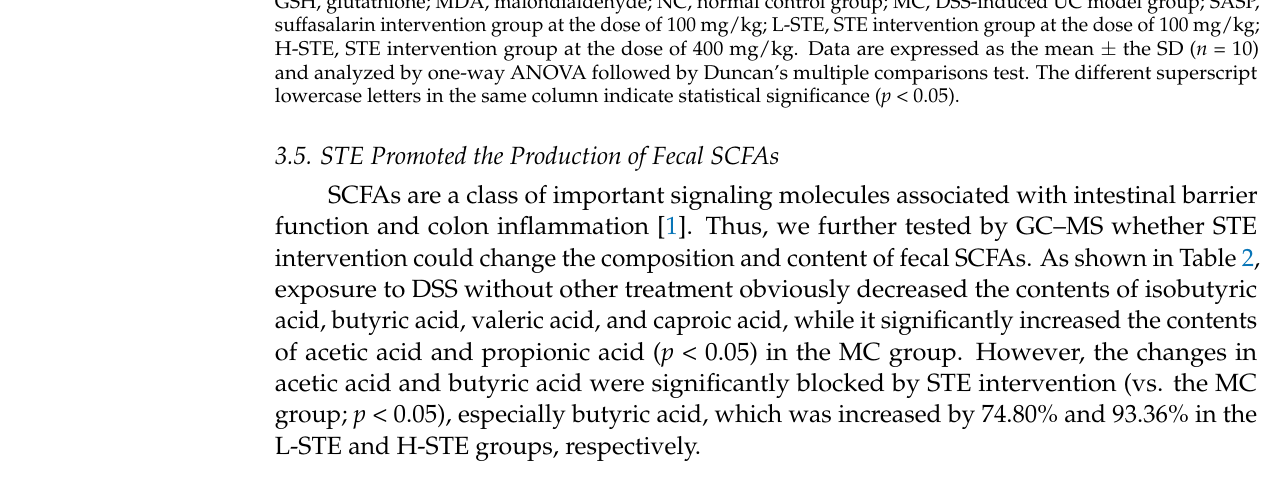
Table 2. Effects of STE on the contents of main fecal